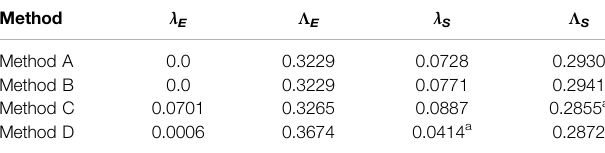
TABLE 3 | Performance indices with regard to the most appropriate ICS constructed by the four methods for HL-1 (2009 Hsiaolin landslide event).